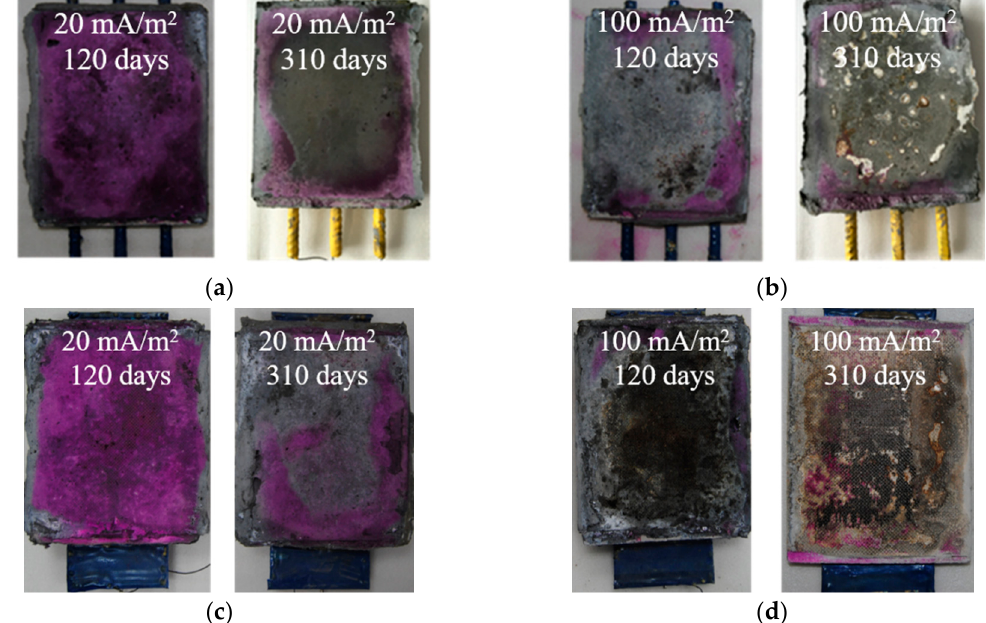
Figure 8. Degradation of the anode interfaces in the chloride-contaminated concrete: ( a ) B-EB-20 specimens; ( b ) B-EB-100 specimens; ( c ) P-EB-20 specimens; ( d ) P-EB-100 specimens.